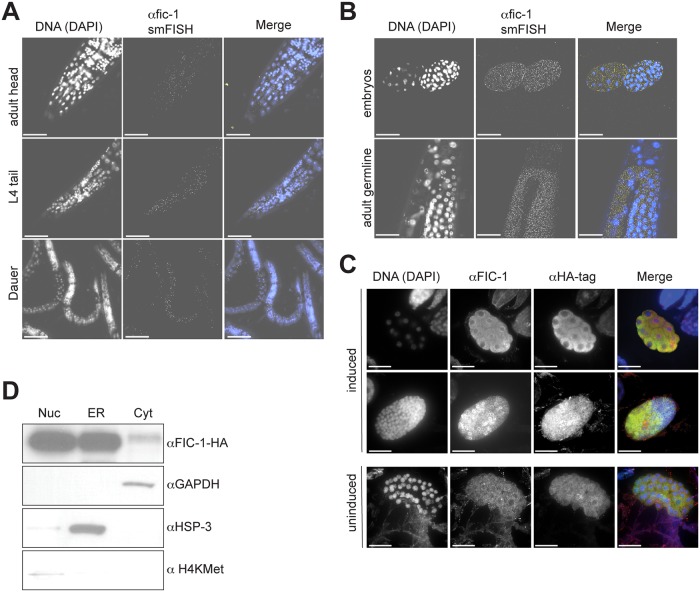
FIC-1 is enriched in the adult germline as well as nematode embryos and localizes to the nuclear membrane.(A) FIC-1 is expressed ubiquitously albeit at low levels: FIC-1 expression pattern as detected by smFISH analysis; samples stained with DAPI (left panel) and smFISH probe (middle panel). Right panel shows merged image where nuclei are represented in blue and smFISH signal in yellow. Distinct representative developmental stages shown here (B) FIC-1 is enriched in the adult germline and embryos: FIC-1 expression pattern as detected by smFISH analysis; samples stained with DAPI (left panel) and smFISH probe (middle panel). Right panel shows merged image where nuclei are represented in blue and smFISH signal in yellow. (C) FIC-1 preferentially localizes to the nuclear envelope/ER: embryos over-expressing HA-tagged FIC-1 were stained with indicated antibodies and dyes and FIC-1 localization was analyzed by confocal microscopy. (D) FIC-1 preferentially localizes to the nuclear envelope/ ER: sub-cellular fraction of C. elegans embryos. Individual fractions probed with indicated antibodies for enrichment of tested proteins. Nuc: nuclear fraction; ER: ER fraction; Cyt: cytosolic fraction.